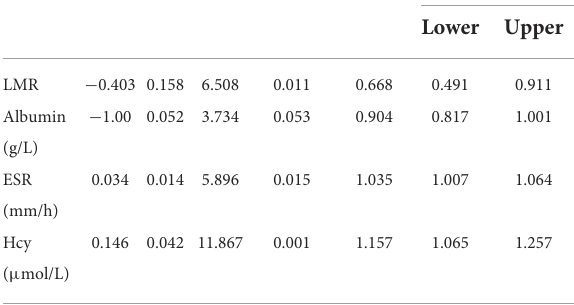
TABLE 6 Univariable logistic regression analysis of factors differentiating patients of first-attack NMOSD with and without CTD. Variables